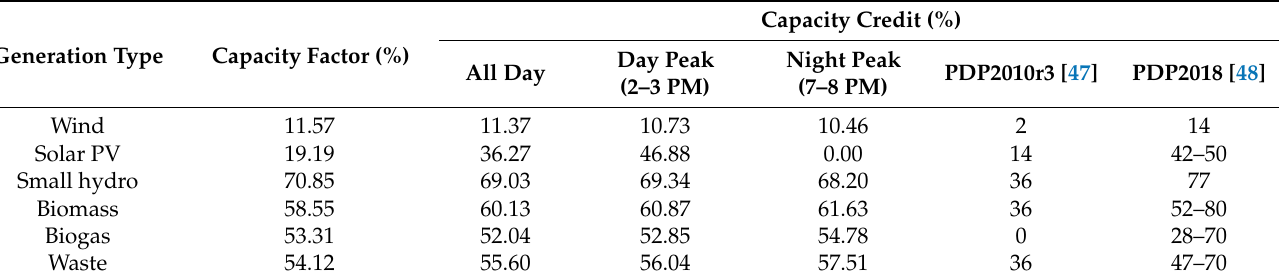
Figure 22. Capacity credit of six RE generation types for different periods and RE capacity sizes: ( a ) wind; ( b ) solar PV; ( c ) small hydro; ( d ) biomass; ( e ) biogas; and ( f ) MSW. Table 2. Capacity credit of RE